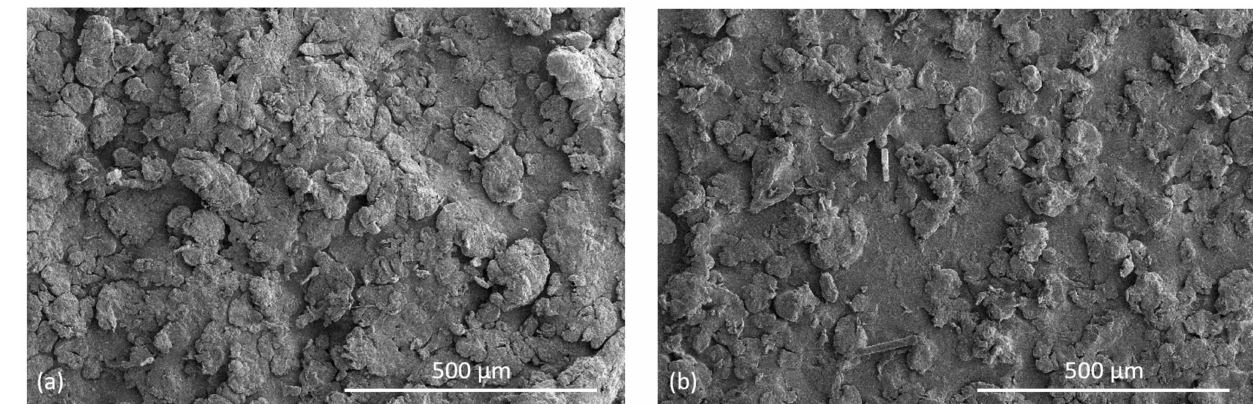
Figure 13. Comparison of top side ( a ) and bottom side ( b ) of a HSS manufactured PET tensile bar.